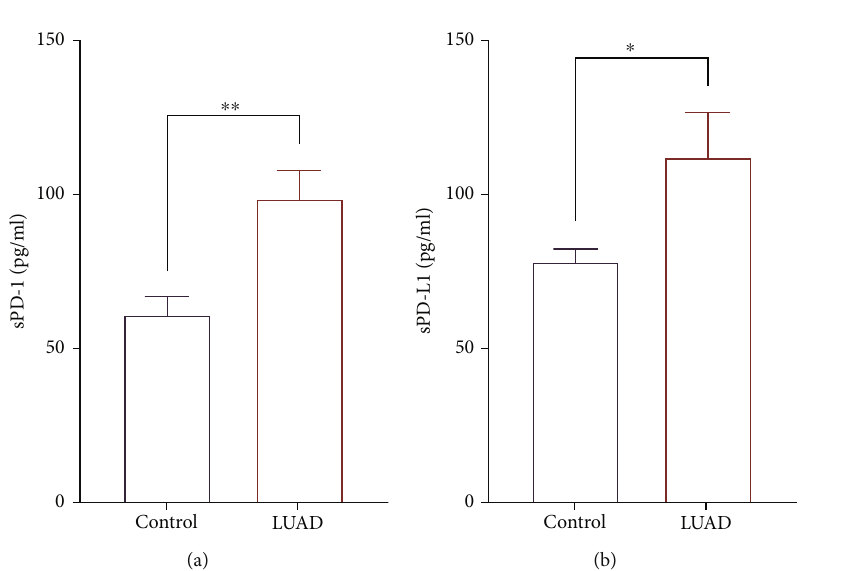
Figure 1: Elevated sPD1 and sPDL1 were found in LUAD patients compared with healthy controls. The protein level of sPD1 (a) and sPDL1 (b) in the serum of patients and controls. Data shown were represented as mean ± SD (all samples were measured in triplicate). ∗∗ P < 0 : 01 , ∗ P < 0 : 05